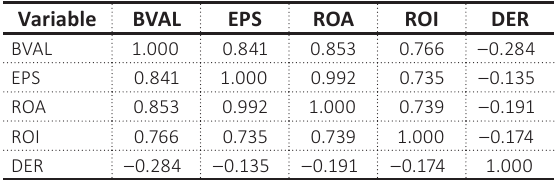
Table 2. Correlation matrix